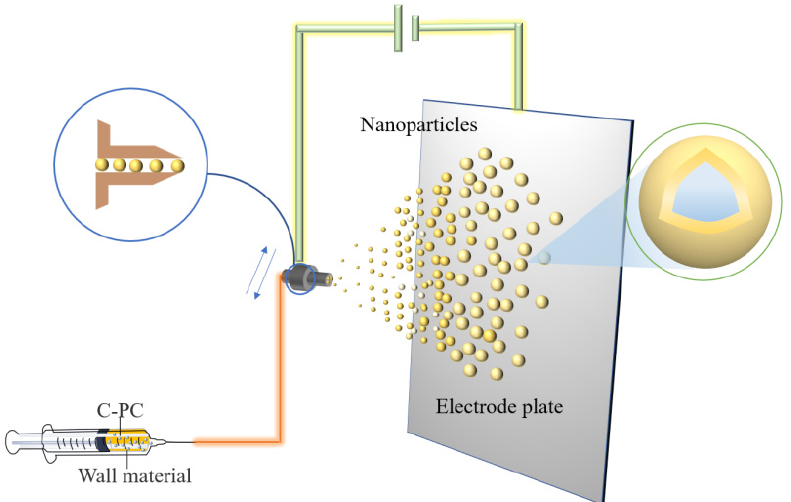
Figure 5. Schematic illustration showing the preparation of PC microcapsules using the electrospraying method.